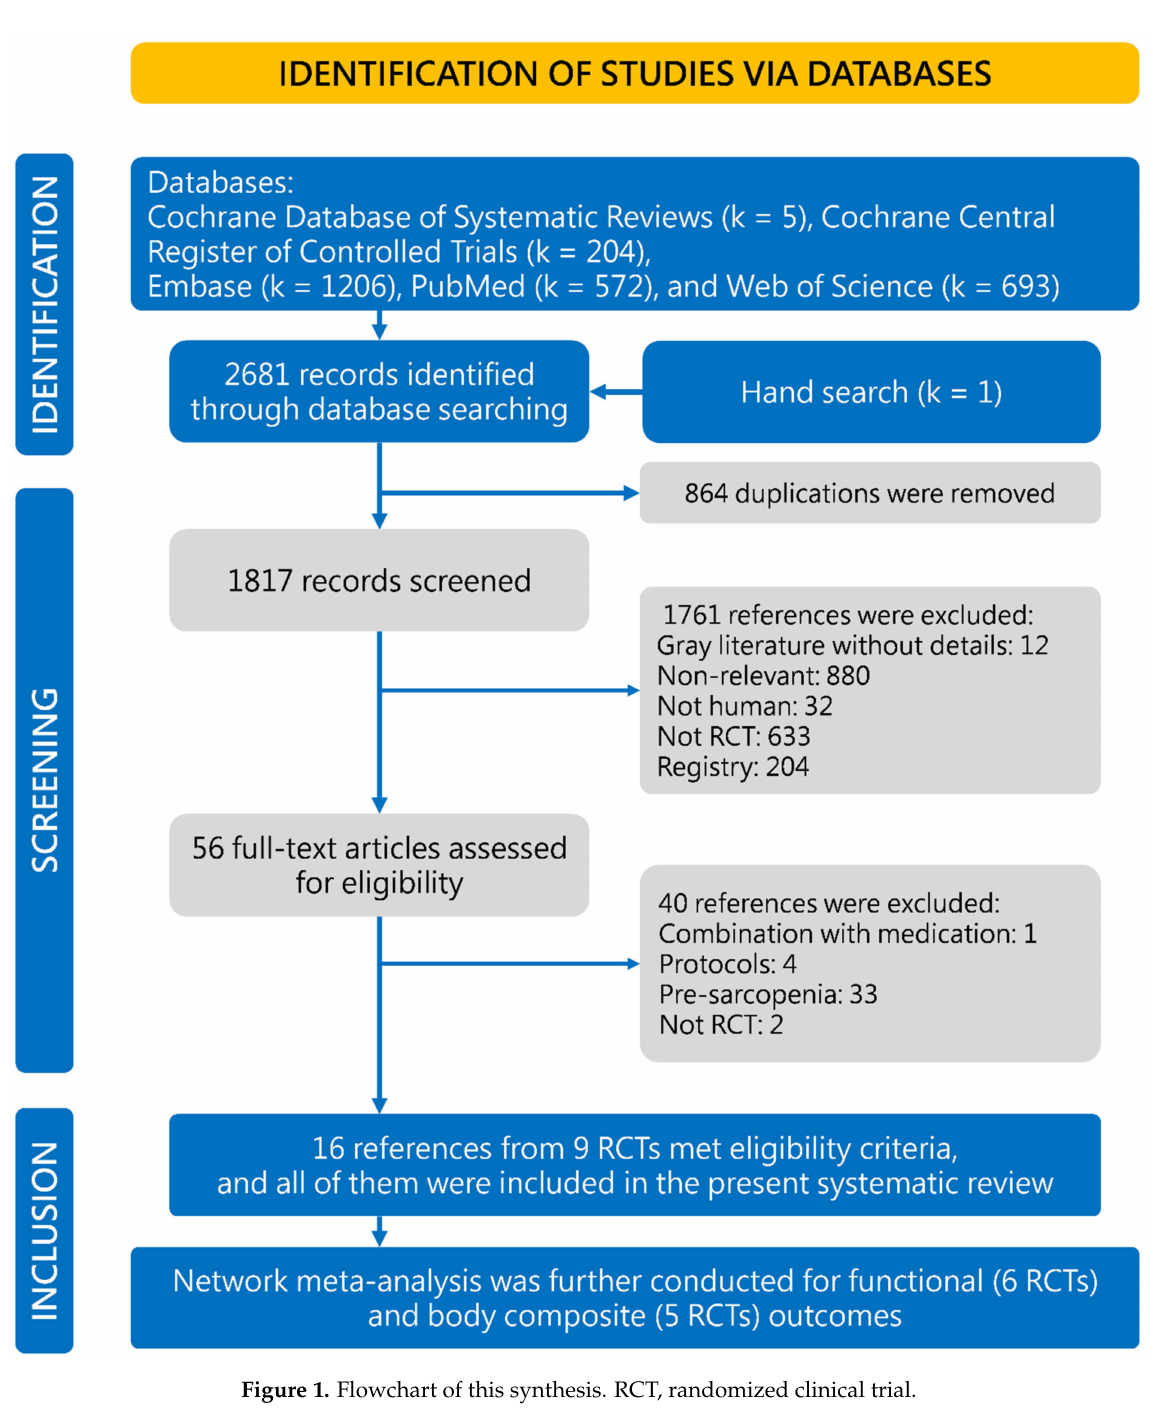
Figure 1. Flowchart of this synthesis. RCT, randomized clinical